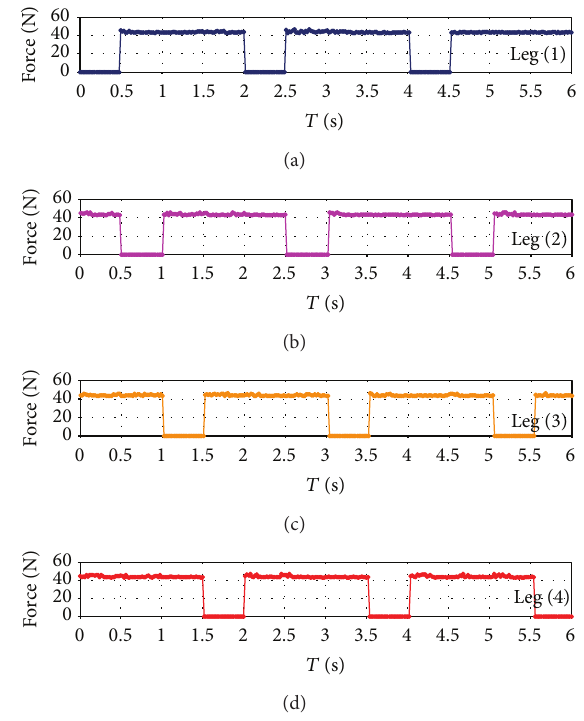
Figure 18: Foot supporting forces when duty cycle is 0.75 and the speed is 2 steps per second.